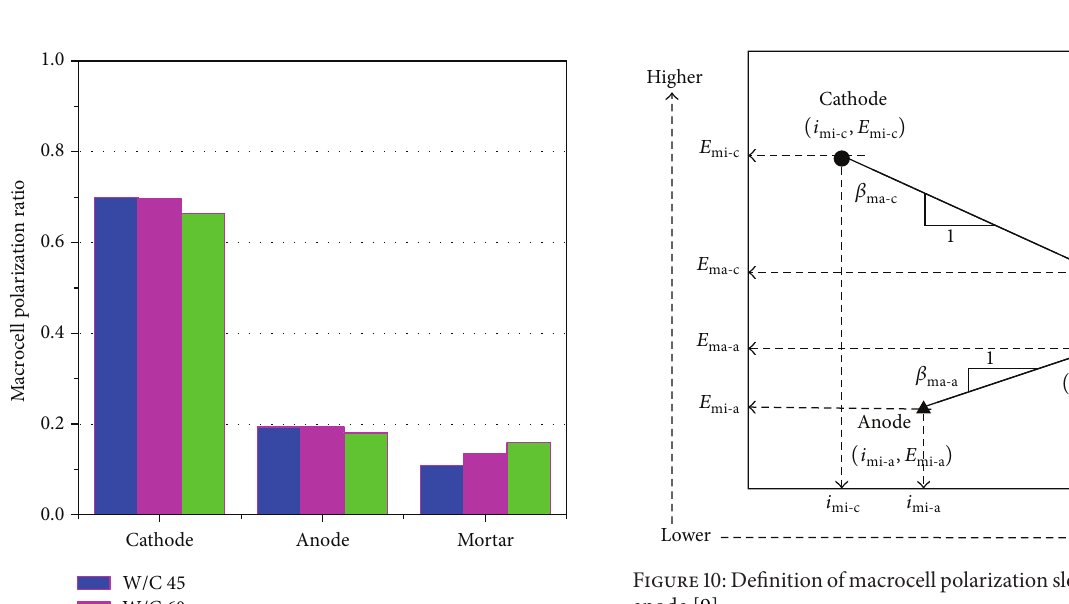
Figure 8: Relationships between Δ𝐸 water-cement ratio = 0.7.